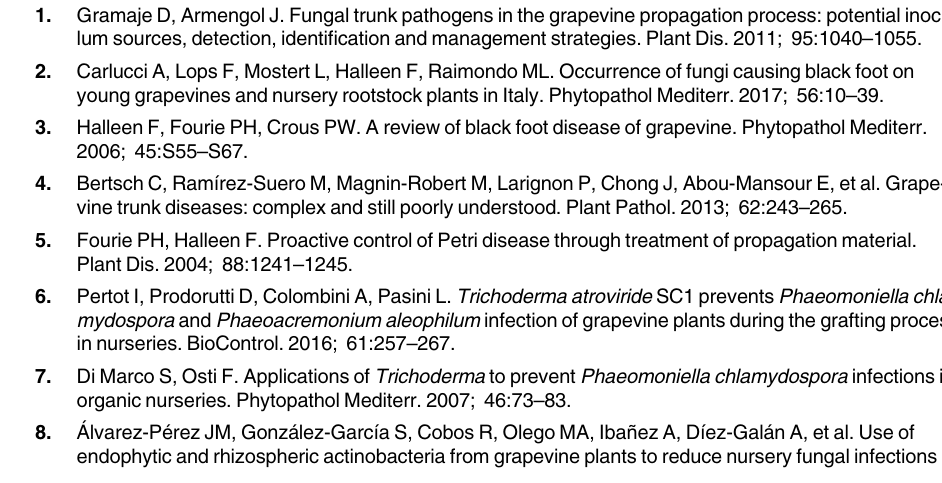
S1 Table. Correlation between mean values of DNA amounts quantified by qPCR from Streptomyces sp. VV/E1 and VV/R4 strains and cell